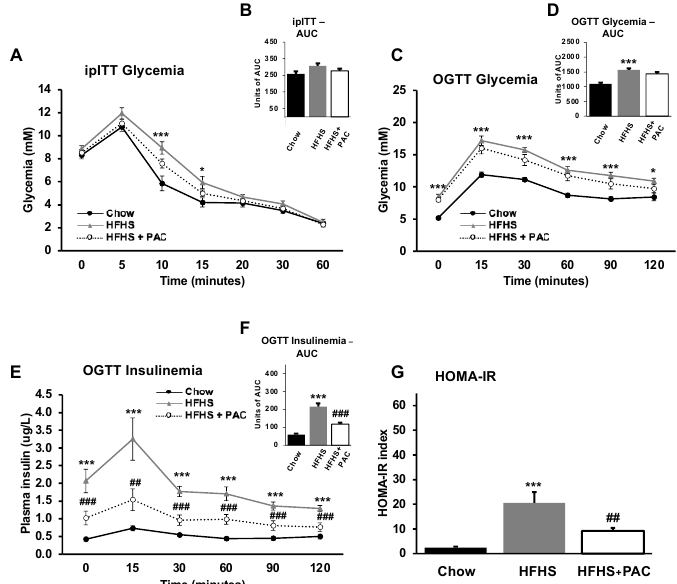
Figure 2. Effect of PAC on glucose homoeostasis and insulin resistance. After 8-week diet, mice were submitted to an intra-peritoneal ( A , B ) insulin tolerance test (ipITT) following a 6 h fast. At week 10, mice were then submitted to an ( C , D ) oral glucose tolerance test (OGTT) following an overnight fast to evaluate ( E , F ) insulinemia. ( G ) The Homeostatic model assessment of insulin resistance (HOMA-IR) was calculated as described in Materials and Methods. Results are presented as mean ± SEM for n = 12 – 16 mice/group. * p < 0.05, *** p < 0.001 vs. chows; ## p < 0.01, ### p < 0.001 vs. HFHS mice. Mice fed a HFHS diet manifested dyslipidemia as reflected by higher lipid profile in plasma TG (Figure 3A) and TC (Figure 3B) as well as TG and TC in VLDL contents (Figure 3C,D) and non-HDL-cholesterol (Figure 3E). The administration of PACs alleviated HFHS-mediated dyslipidemia, with an elevated trend in levels of HDL-cholesterol (Fig- ure 3F).